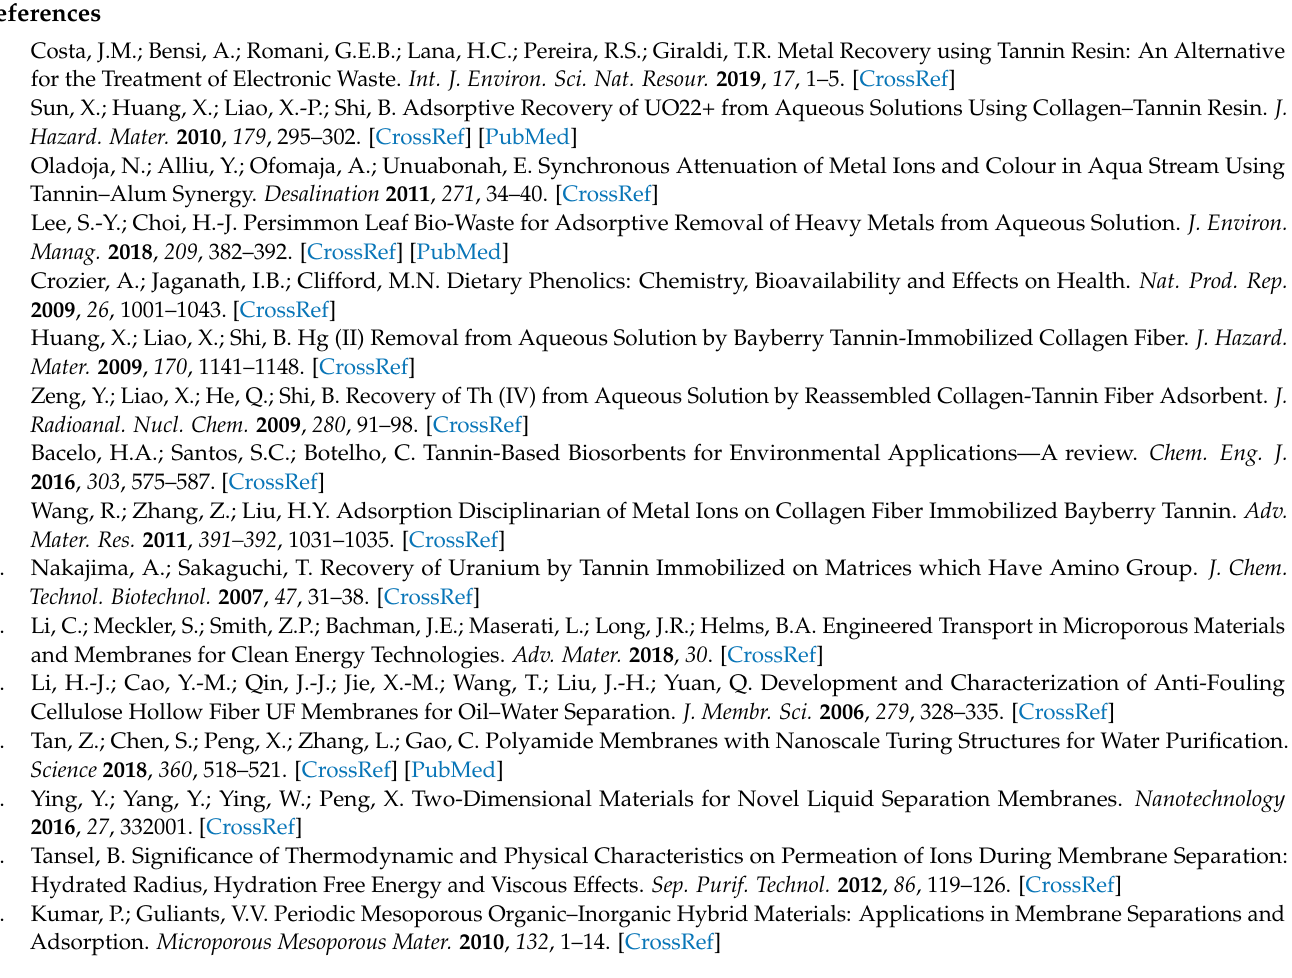
Schematic illustration showing the preparation of PVDF-BWT, Schematic S4: Schematic illustration showing the preparation of CELL-BWT, Figure S1: The FTIR spectra of (a)PA and PA-BWT, (b) PA and PA-AA-BWT, (c) PVDF and PVDF-BWT, (d) CELL and CELL-BWT, Figure S2: Adsorption capacity of UO 22+ on different M-TANs: the initial concentration of the UO 22+ solution is 1 mmol L -1 , the pH is 5.0, and the adsorption time is 24 h, Figure S3: Adsorption kinetics regression by the Weber-Morris model: q t = k ip t 1/2 + C, where q t (mmol/g) are the adsorption capacity of UO 22+ at time t , k ip is Internal diffusion rate constant and C is a constant of the surface boundary layer thickness of the adsorbed material, Figure S4: Digital photos of different M-TAN before and after long-term shaking and soaking at different temperatures (a) 20°C, (b) 50°C, and pH (c) pH=2, (d)